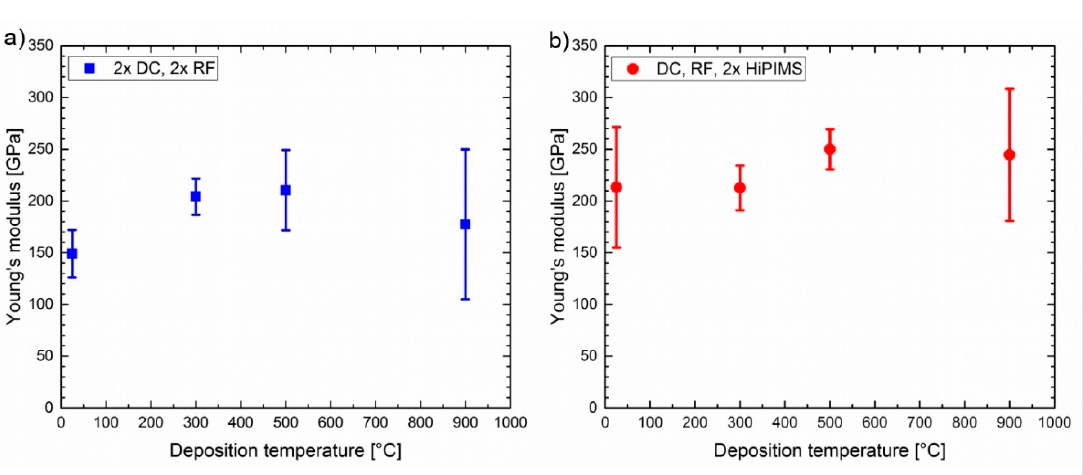
Figure 7. Young’s modulus values as determined by nanoindentation of films deposited at different temperatures, indicating the average, maximum, and minimum of 10 measurements: ( a ) cathodes powered by two DC and two RF plasma generators, ( b ) cathodes powered by one DC, one RF, and two HiPIMS generators.